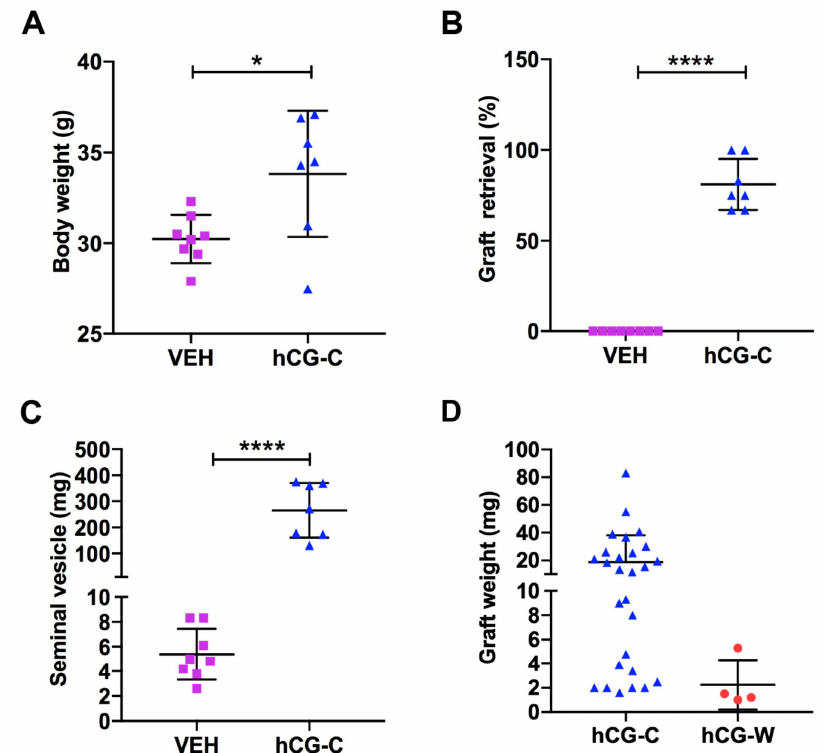
Figure 1. ( A ) Body weight of host mice from ‘Untreated’ vehicle (VEH, n = 8) and ‘Continuous hCG’ (hCG-C, n = 7) groups. ( B ) Graft retrieval rate from individual host mice in ‘Untreated’ ( n = 8) and ‘Continuous hCG’ ( n = 7) groups. ( C ) Seminal vesicle weight of host mice from ‘Untreated’ ( n = 8) and ‘Continuous hCG’ ( n = 7) groups. ( D ) Graft weights from ‘Continuous hCG’ (hCG-C, n = 27) and ‘Withdrawal hCG’ groups (hCG-W, n = 4). * p < 0.05, **** p <